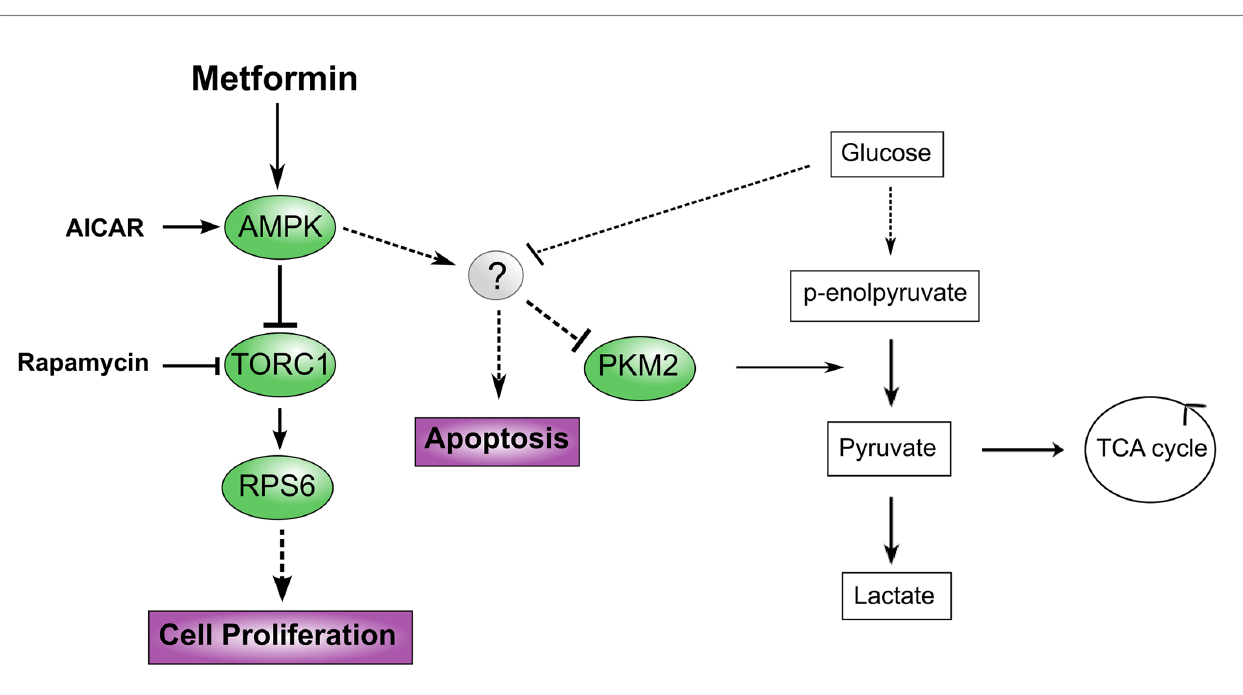
Fig 7. Model consistent with the data presented in this manuscript. The model represents the logic relationships that are supported by the experimental observations presented here. Solid and broken lines in the left “ signalling ” part of the model represent direct and indirect interactions, respectively. Activations and inhibitions are depicted as arrowhead and hammerhead. On the right “ metabolic ” part of the model arrows represents metabolite conversions. The circle with a question mark represents the unknown entity that mediate the downregulation of PKM2 when AMPK is activated at high glucose